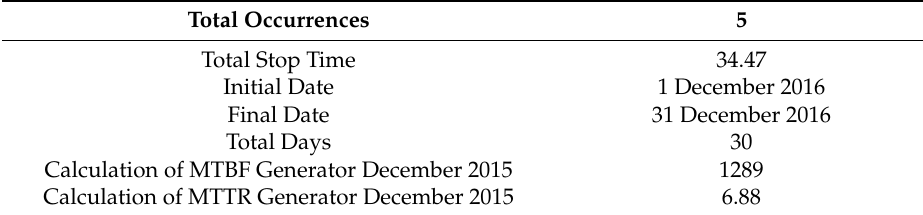
Table 7. Calculation of MTBF and MTTR, December 2016.